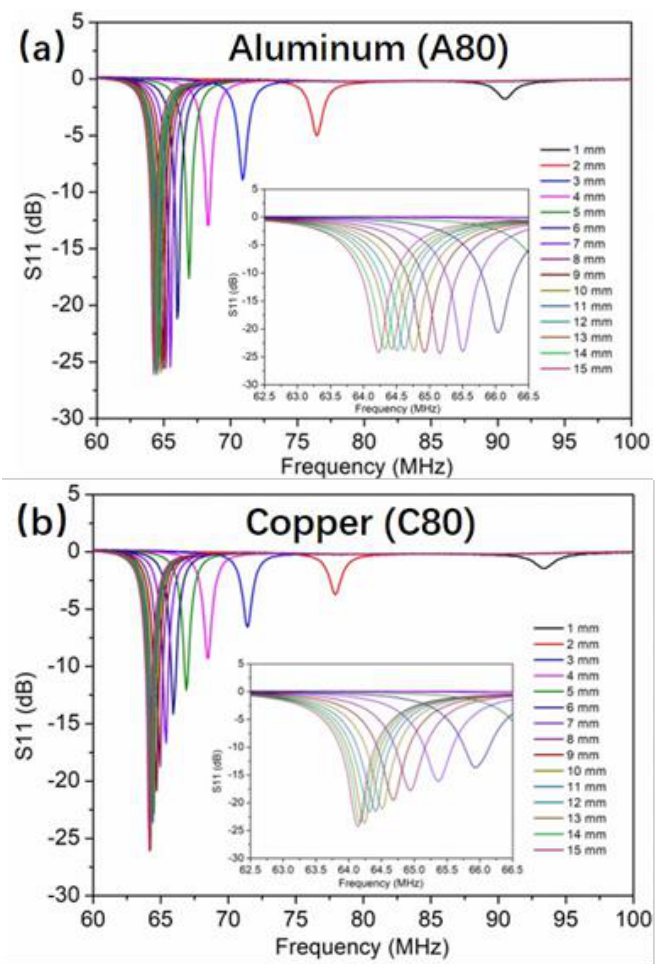
Figure 4. Response of the LC proximity sensor for the target of ( a ) A80 and ( b ) C80 at different testing distances. Sensors 2019 , 19 , x FOR PEER REVIEW